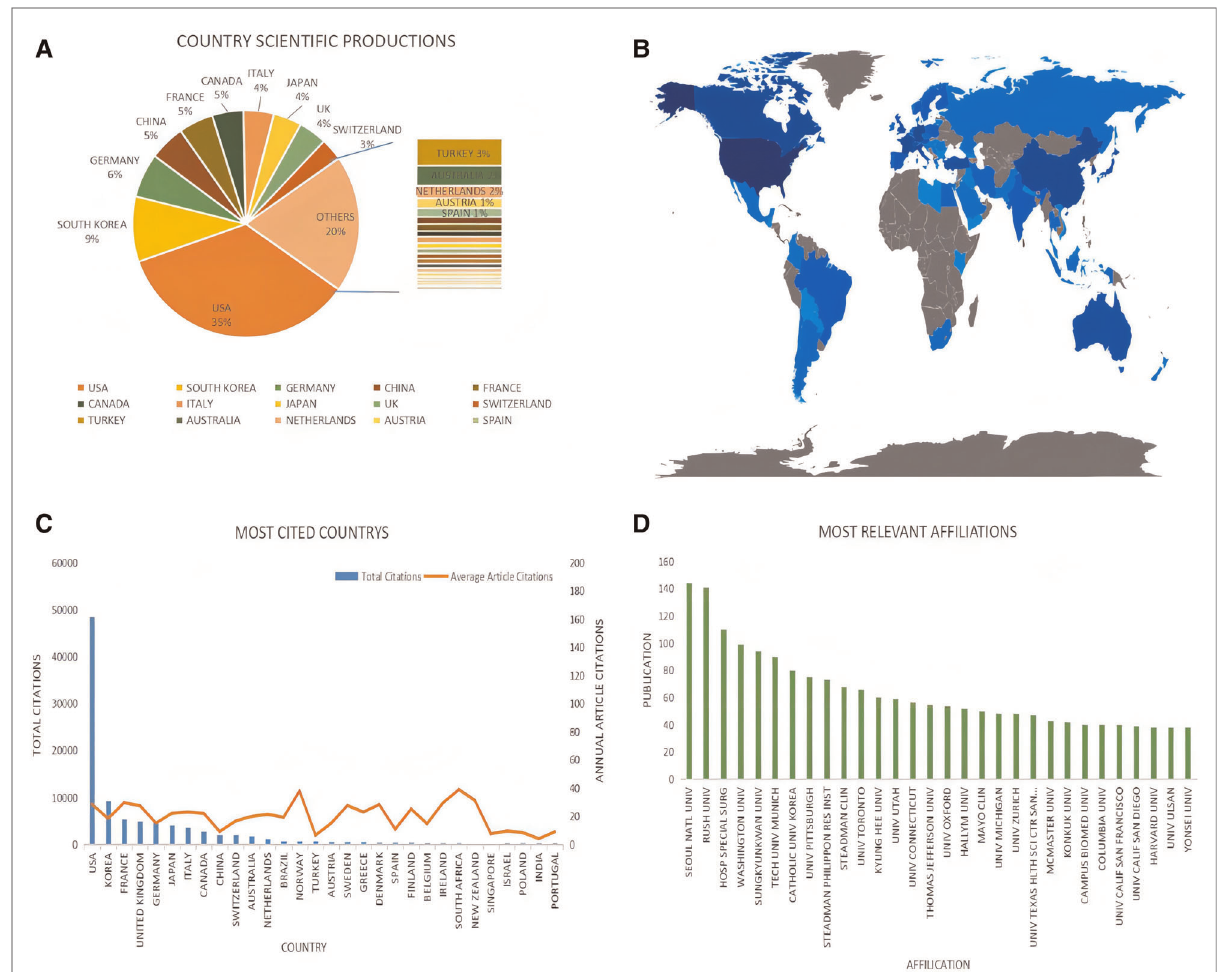
FIGURE 3 Country and institution analysis of arthroscopic therapy of rotator cuff diseases related publications from 2002 to 2021. ( A ) The production proportion of contributing countries. ( B ) Heat Map of the country ’ s scienti fi c productions. ( C ) The total citations and annual article citations of the top 50 countries. ( D ) The number of publications of the top 30 most relevant